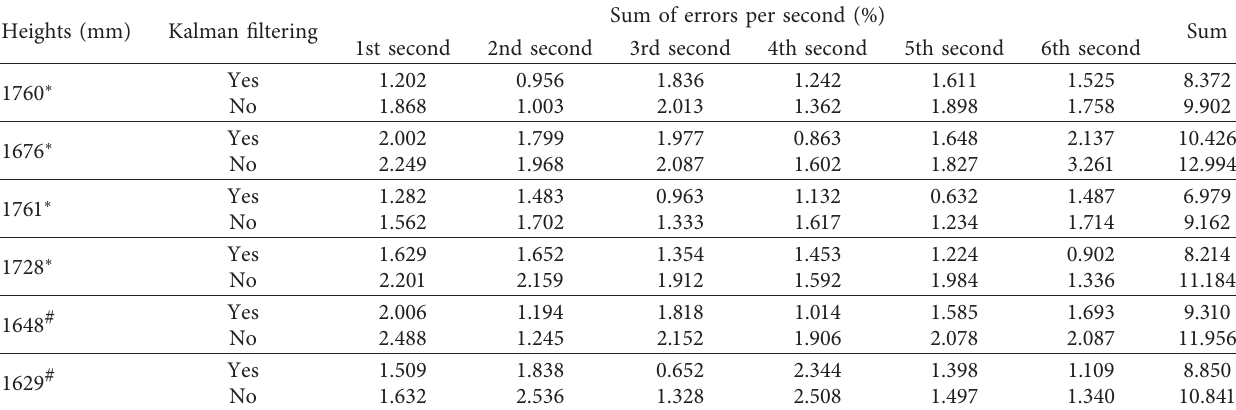
Table 2: The sum of errors per second of the algorithms with and without Kalman filtering. Heights